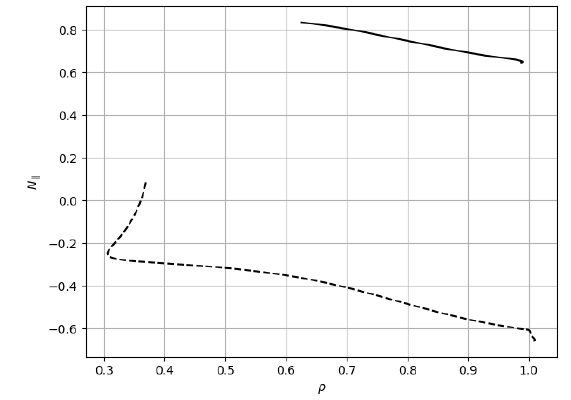
Figure 8. 𝑁 ∥ evolution across the EBW ray trajectory for two rays giving maximum current drive at ρ = 0.45 (dashed) and ρ = 0.75 (solid) for SPR-008. Both rays start with |𝑁 ∥ |~0.65 . The ray traces continue beyond the point of absorption but there is no power left in the